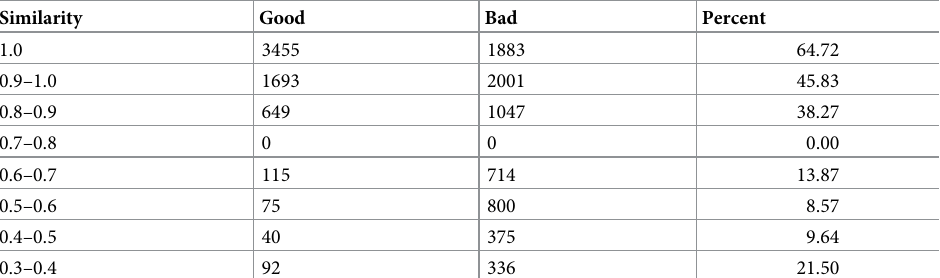
Table 2. Relationship between seed similarity and genome similarity. The correspondence between pheS similarity on the number of high-quality and total bins found. In general, the further the reference is from the original genome, the more likely it is that the bin will not be high-quality. A pheS similarity of 0.3 is sometimes smaller than a species and sometimes larger, but it is usually inside the same genus. In general, it should be expected that the binning service will do very well retrieving bins with pheS similarity greater than 0.8 , and is able to retrieve high quality bins at dis- tances as far as 0.3 in some cases. No high-quality bins were retreived with pheS similarity below 0.3